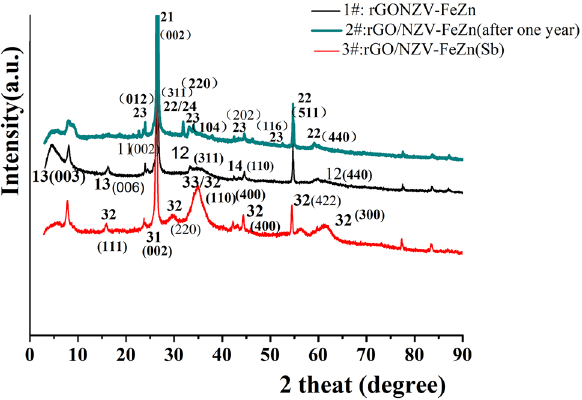
Figure 8. XRD patterns for rGO/ NZV-FeZn (1#: 20180091803, 2#: rGO/NZVFeZn (2019111402) and 3#: rGO/NZV-FeZn(Sb,